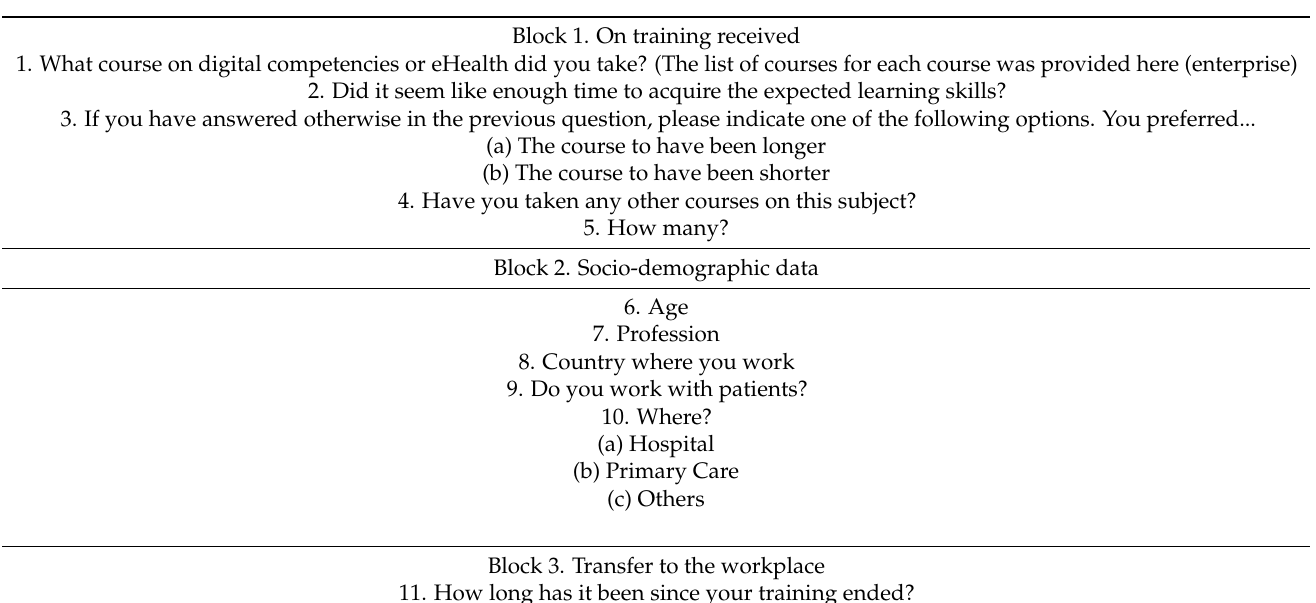
Table A1. Sections and questions of the survey